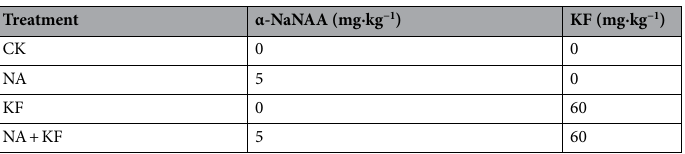
Table 1. Experimental design and treatment combination of α-NaNAA and KF. The purity of KF (Xinjiang Shuanglong Humic Acid Factory, Wulumuqi, Xinjiang, China.) was 45%. The purity of α-NaNAA (Henan Zhenrui Biological Technology Co., Ltd, Zhoukou, Henan, China) was 99.99%, NA, 5 mg·kg −1 α-NaNAA;